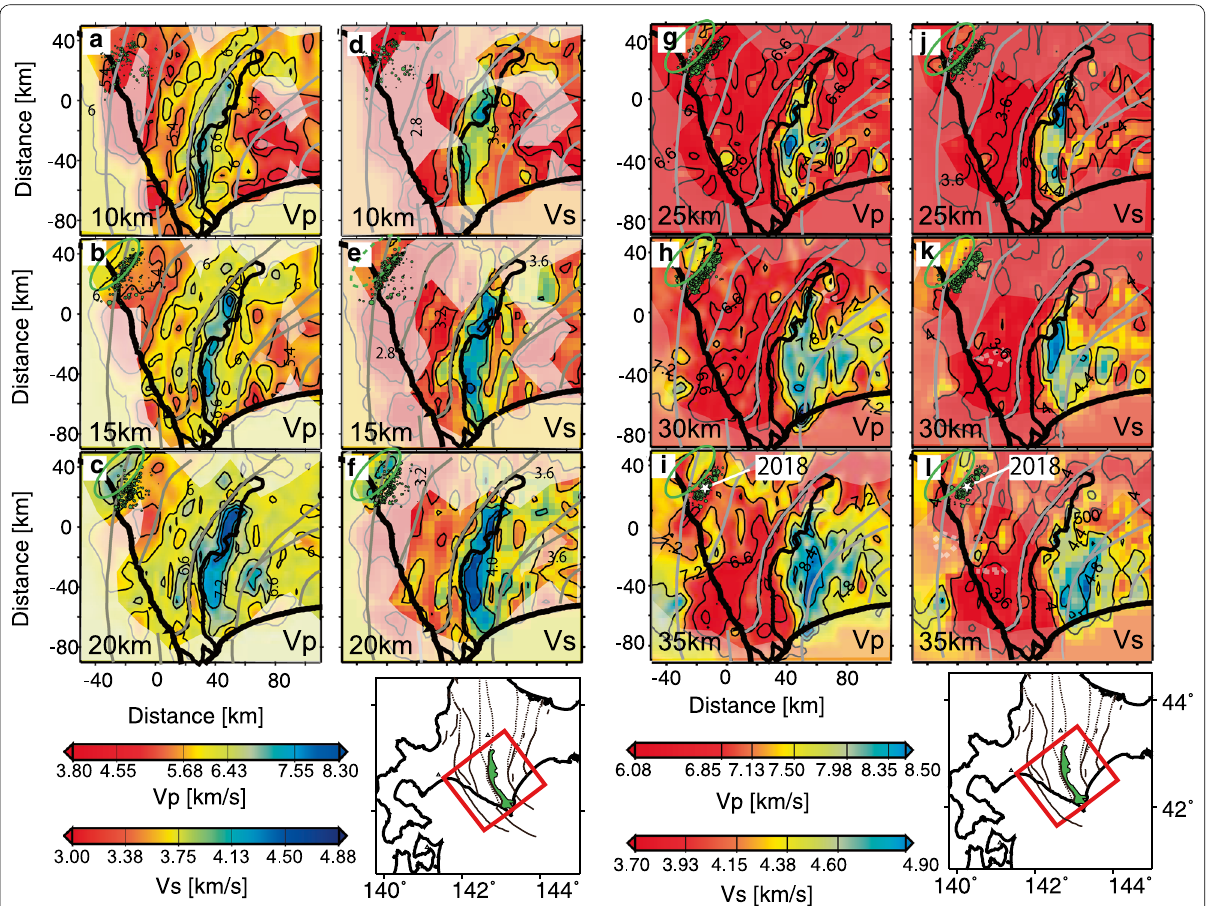
Fig. 5 Relocated hypocenters in the present study plotted on the horizontal cross-sections of P and S wave velocities estimated by Kita et al. (2012). Green dots indicate the hypocenters of aftershocks within 2.5 km in the depth direction, and the white stars in i and l indicate the mainshock. The P wave velocities are shown at depths of 10, 15, 20, 25, 30, and 25 km in a – c and g – i , respectively. The S wave velocities at these depths are shown in d – f and j – l . Note that the color scales for a – f are different from those for g – l . Contours indicate P and S wave velocity values at intervals of 0.6 and 0.4 km/s, respectively. Green and green dashed ellipses indicate the location of intrusion of the high-velocity materials. Gray lines indicate the locations of thrust faults. The black area and thick black lines indicate the locations of the Hidaka metamorphic belt and the coast line, respectively. White-shaded areas indicate portions of DWS <